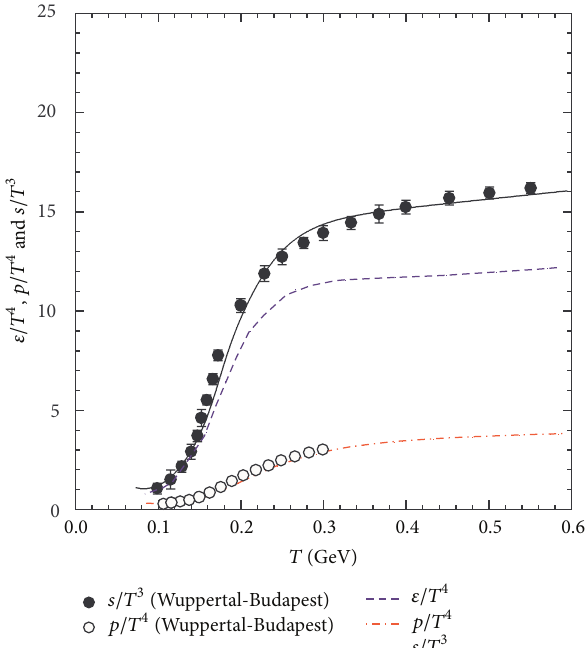
Figure 2: Lattice simulations [6] for energy density and entropy density are shown. The lines are parameterised EOS. For details of the parametric EOS, see